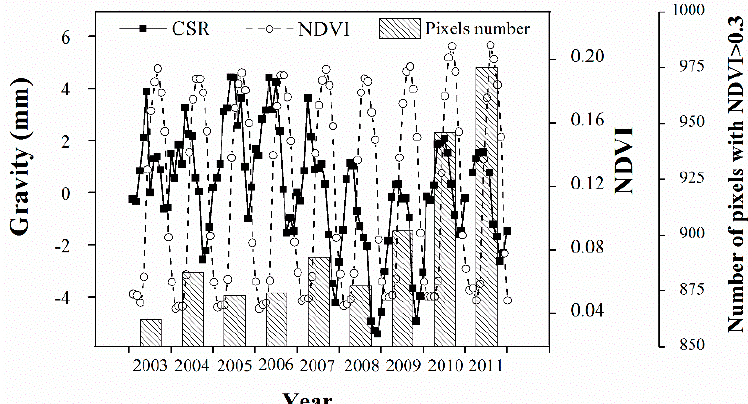
Table 2. Regression coefficients of NDVI models with temperature, precipitation and gravity from 2003 to 2011. Figure 6. Spatial distribution of GRACE gravity trends in equivalent water thickness based on three solutions: ( a ) Center for Space Research (CSR); ( b ) German Research Center for Geosciences (GFZ); and ( c ) Jet Propulsion Laboratory (JPL). Areas significant at the 95% level are highlighted.